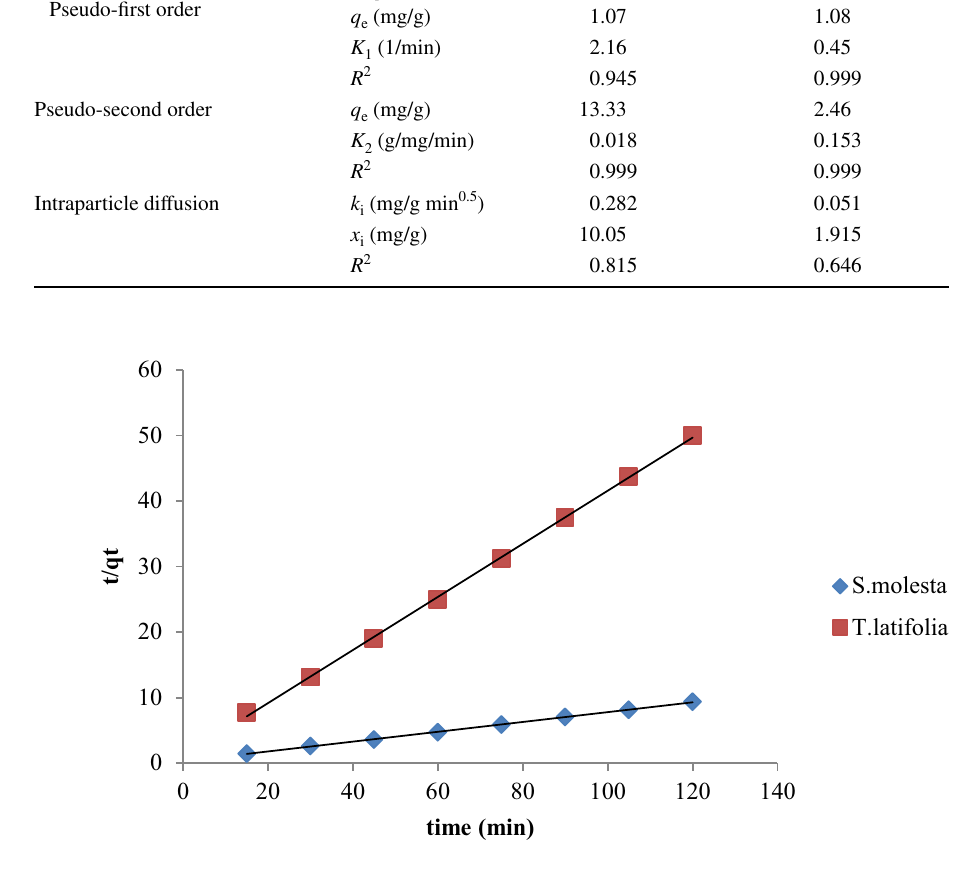
Table 2 Comparison of kinetic parameters for both adsorbents